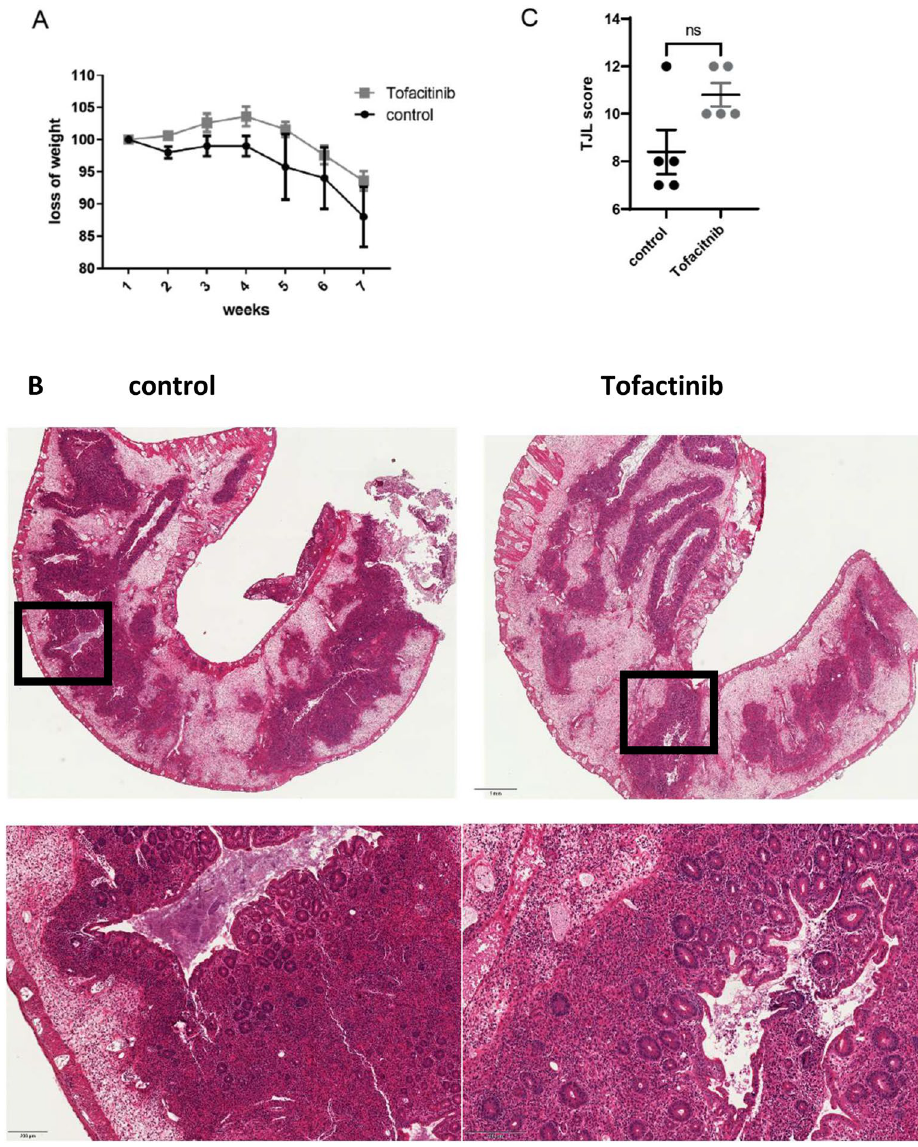
Figure 1. Low-doses of tofacitinib has no effect on disease activity in experimental colitis. Rag−/− mice were adoptively transferred with CD4 + CD25-wild-type cells. Mice were weighed weekly and sacrificed 7 weeks after transfer. ( A ) Loss of body weight, two-tailed unpaired t-test were used to test for significance (one experiment with N = 4 controls, N = 5 Tofacitinib treated mice). ( B ) Representative histology of colon tissue (left: control, right: tofactinib), ( C ) Results of histological TJL (The Jackson Laboratory Score) scoring of colon